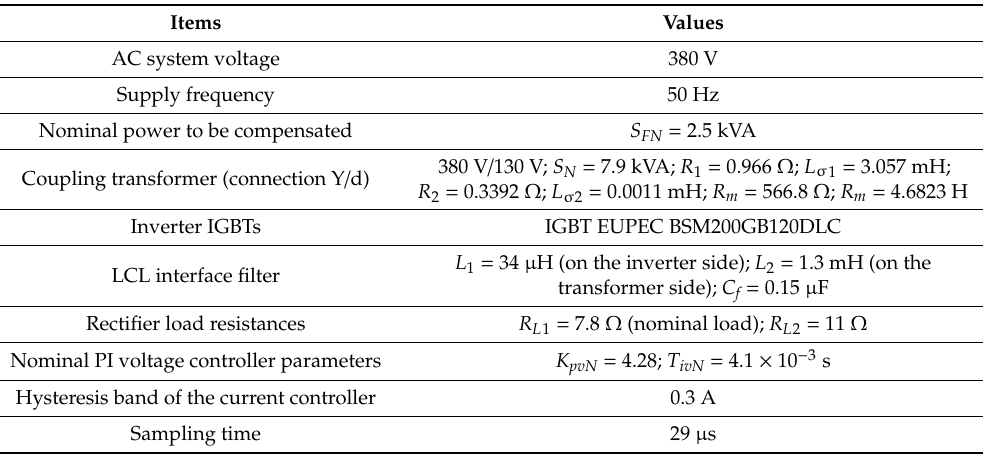
Table 4. The main parameters of the system.